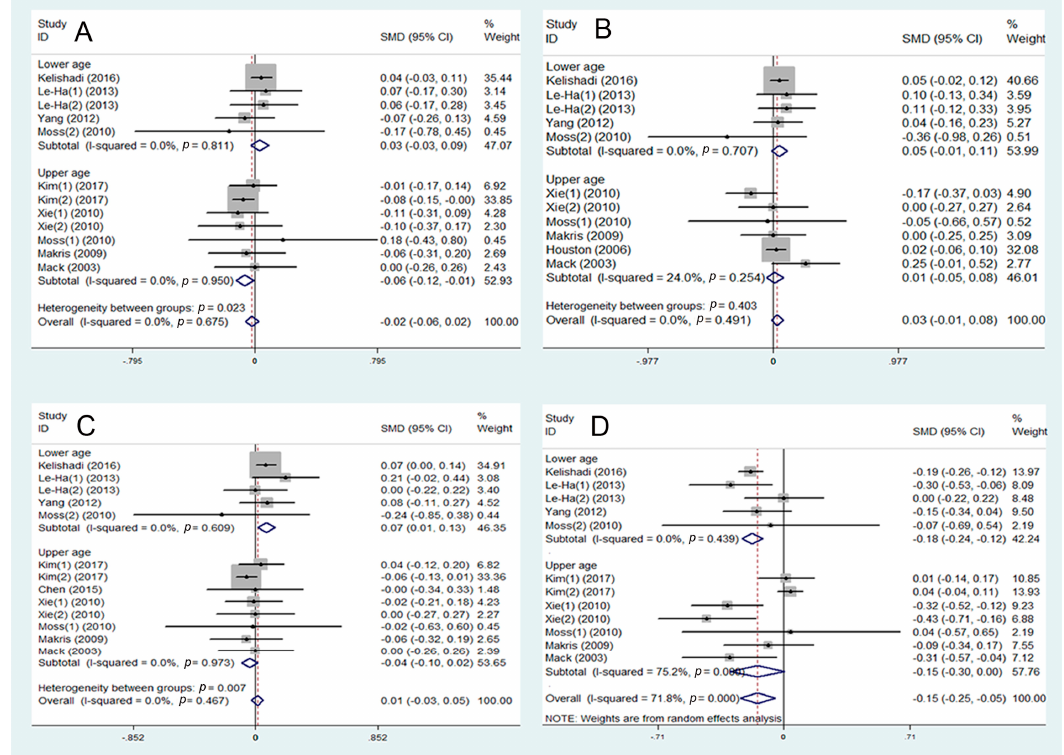
Figure 3. Meta-analysis of secondhand smoke (SHS) and risk of lipid metabolism disorder: ( A ) association between SHS and total cholesterol; ( B ) association between SHS and triglycerides; ( C ) association between SHS and LDL-C; ( D ) association between SHS and HDL-C. WMD—weighted mean difference; SMD—standard mean difference.